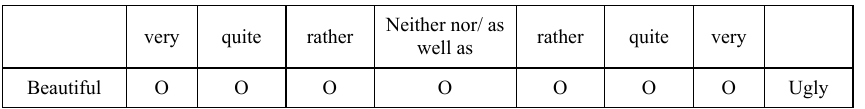
Table 5: Item beautiful-ugly of the questionnaire for capture the aesthetical